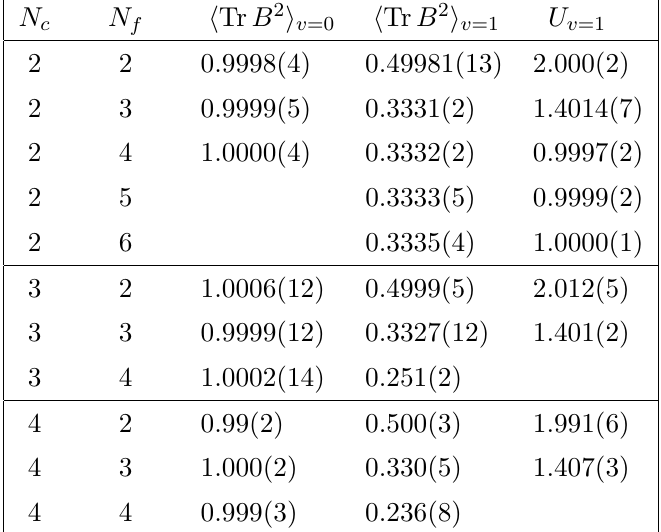
Table 1 . Results for h Tr B 2 i and the Binder parameter U in the large- β limit. We consider a square x lattice of size L = 4 , two values of v , v = 0 and v = 1 , and γ = 0 . The values of U v =1 that differ from 1 are consistent with eq. (3.17), which predicts U = 2 and 7/5 for N f = 2 and 3,